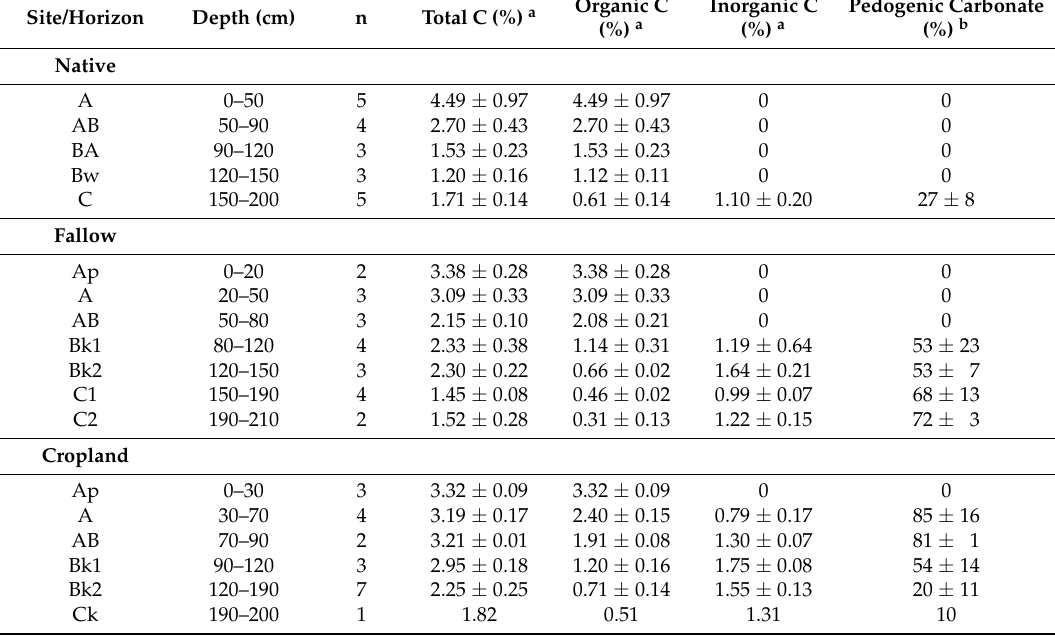
Table 5. Soil carbon (mean ± standard deviation) distribution with depth and site in the representative soil profiles.